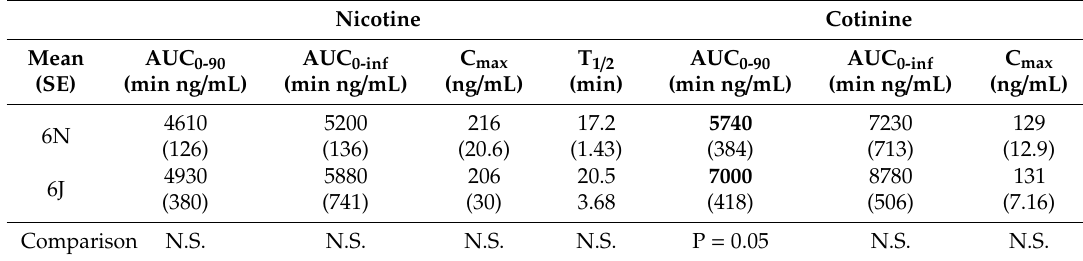
Figure 4. The time course of nicotine and cotinine in male B6J and B6N mice. The rate of nicotine metabolism is not significantly di ff erent in the B6J and B6N substrains. Nicotine metabolism was measured by quantifying the production of cotinine after drug administration. Mice were subcutaneously injected with nicotine (1 mg / kg) and had their blood collected at 5, 15, 30, and 60 min after injection. Nicotine levels were measured at 5, 15, 30, 60 min time points. Each time point represents the mean + SEM of six mice per group. Table 2. Summary of pharmacokinetic parameters after acute nicotine administration (1 mg / kg, s.c.) in male B6J and B6N mice. Statistical comparisons were performed using two-tailed t-test. N.S = Not